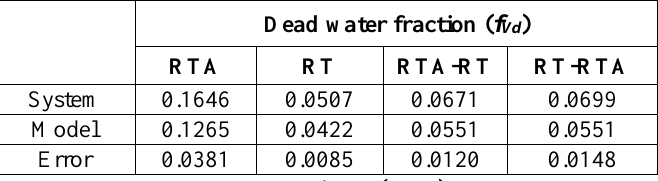
Table 1: Dead water fraction for the studied cases: RTA, RT and their serial